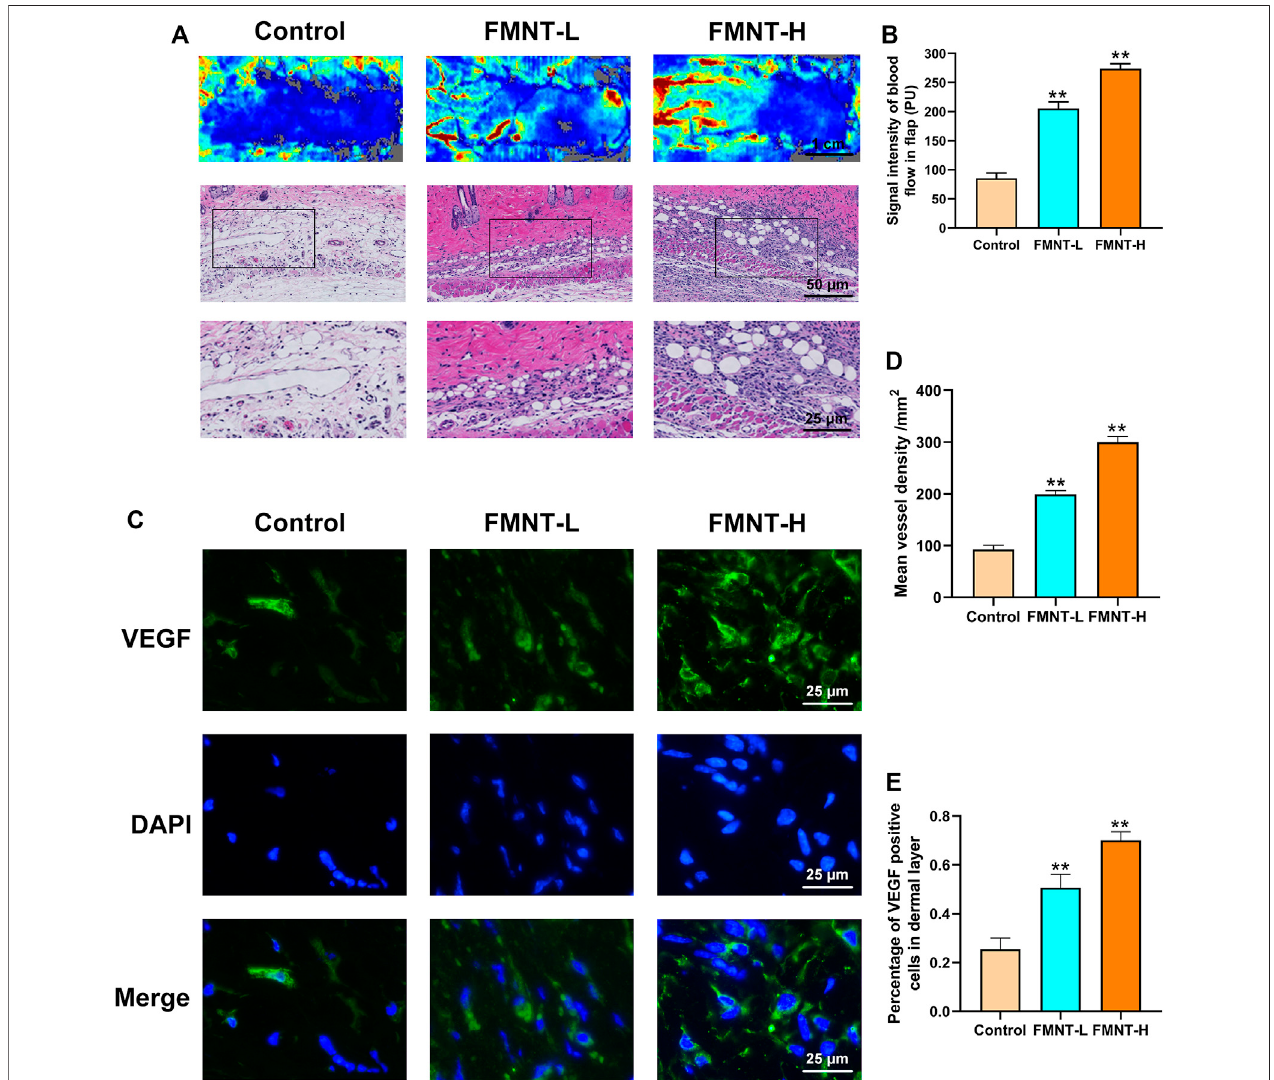
FIGURE 4 | FMNT increased blood vessels in fl aps (A) Laser Doppler images show blood perfusion in the fl ap (scale bar: 1 cm) The H&E staining between three groupsshowingthevessels(scalebar:50and25 μ m) (B) Signalintensityofblood fl owinskin fl apsamongthethreegroups (C) Therepresentative fl uorescenceimageof VEGF withDAPI (nuclei) (scalebar: 25 μ m) (D) Mean vessel density ofmice skin fl ap tissue (E) Thepercentage ofVEGF positivecells indermallayerofskin fl aps. All data represent mean ± SD. ** p ≤ 0.01 compared to the control group.